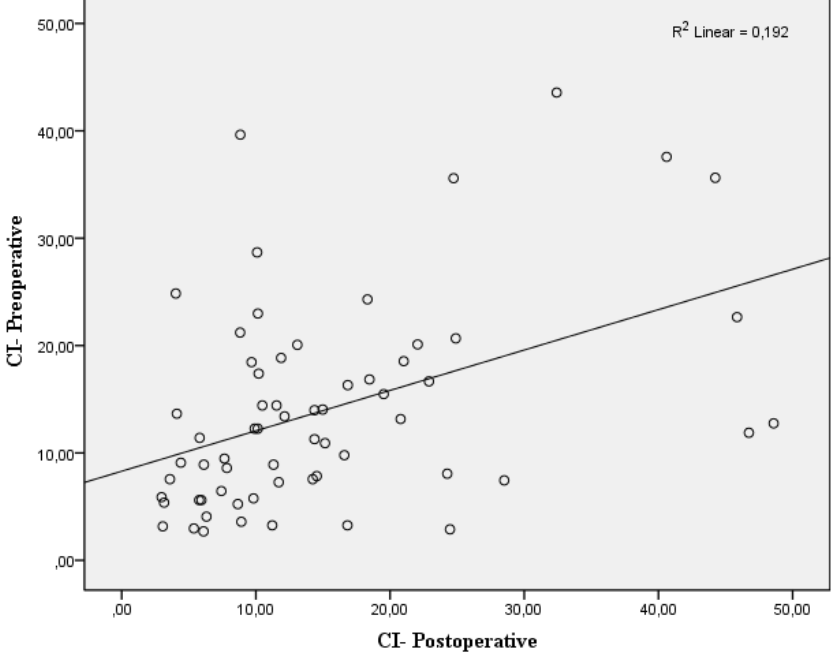
Figure 4. Correlation of the collapsibility index (CI) of inferior vena cava between preoperative and postoperative period. p < 0.01.